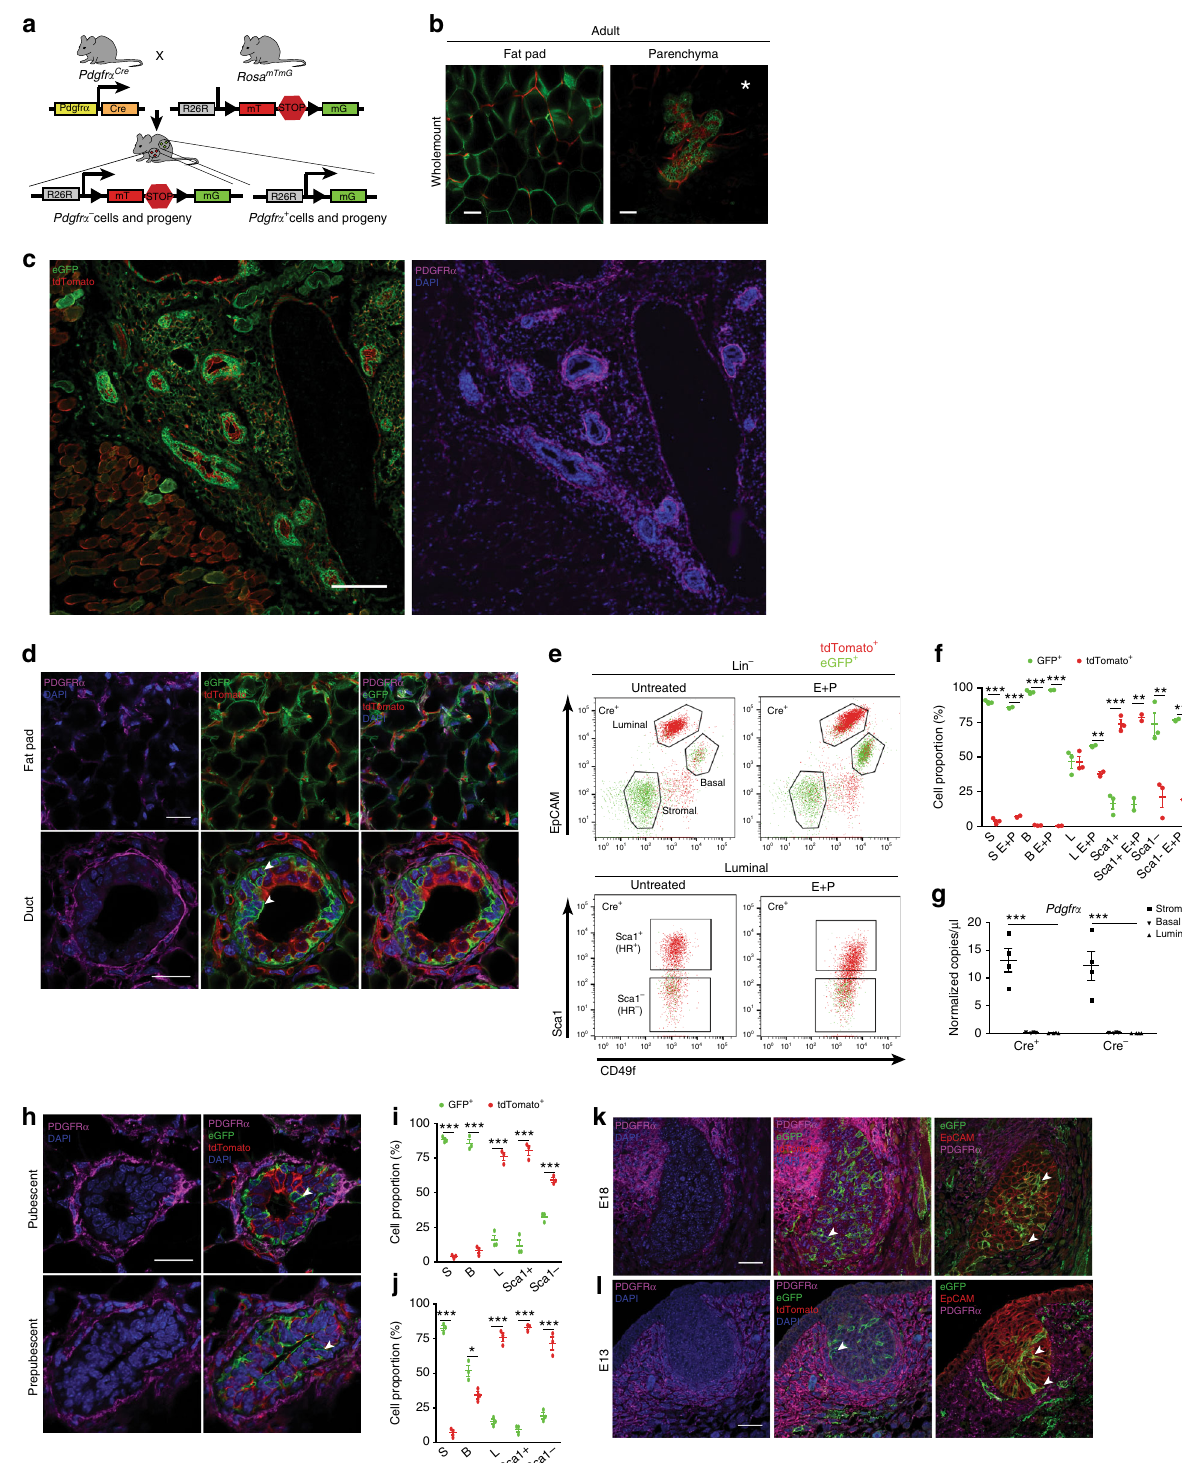
epithelial compartments in addition to stroma, and dominated patterns of PDGFR α + cells in relation to GFP + progeny. Speci- fi cally, PDGFR α + cells were dispersed in the fat pad and adjacent the basal compartment and Sca1 - luminal progenitor subset, both to ducts, yet restricted to stroma while GFP + cells comprised of which are generally hormone-receptor negative (Fig. 2e, f and PDGFR α + stromal cells, adipocytes and epithelial cells (Fig. 2c, d Supplementary Fig. 2b). Given this unexpected occurrence of PDGFR α + stromal and Supplementary Fig. 2a). GFP + PDGFR α - cells were found in both the basal and luminal epithelial layers, with luminal GFP + progeny in epithelia, we performed ddPCR on FACS-puri fi ed mammary subsets from Cre + mice and Cre - controls to measure cells being primarily PR - (Supplementary Fig. 2a). FACS enu- meration demonstrated that GFP + progeny was present in Pdgfr α expression in our lineage tracing study; Pdgfr α transcript NATURE COMMUNICATIONS| (2019) 10:1760